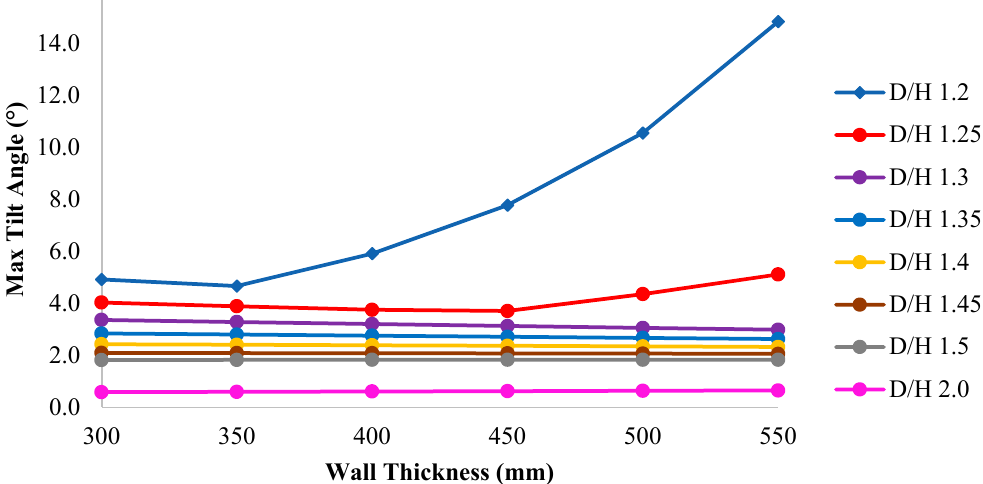
Figure 22. Effect of wall thickness on tilting angle for 15,000 m 3 tank (L/D = 1.05) under extreme environmental condition.